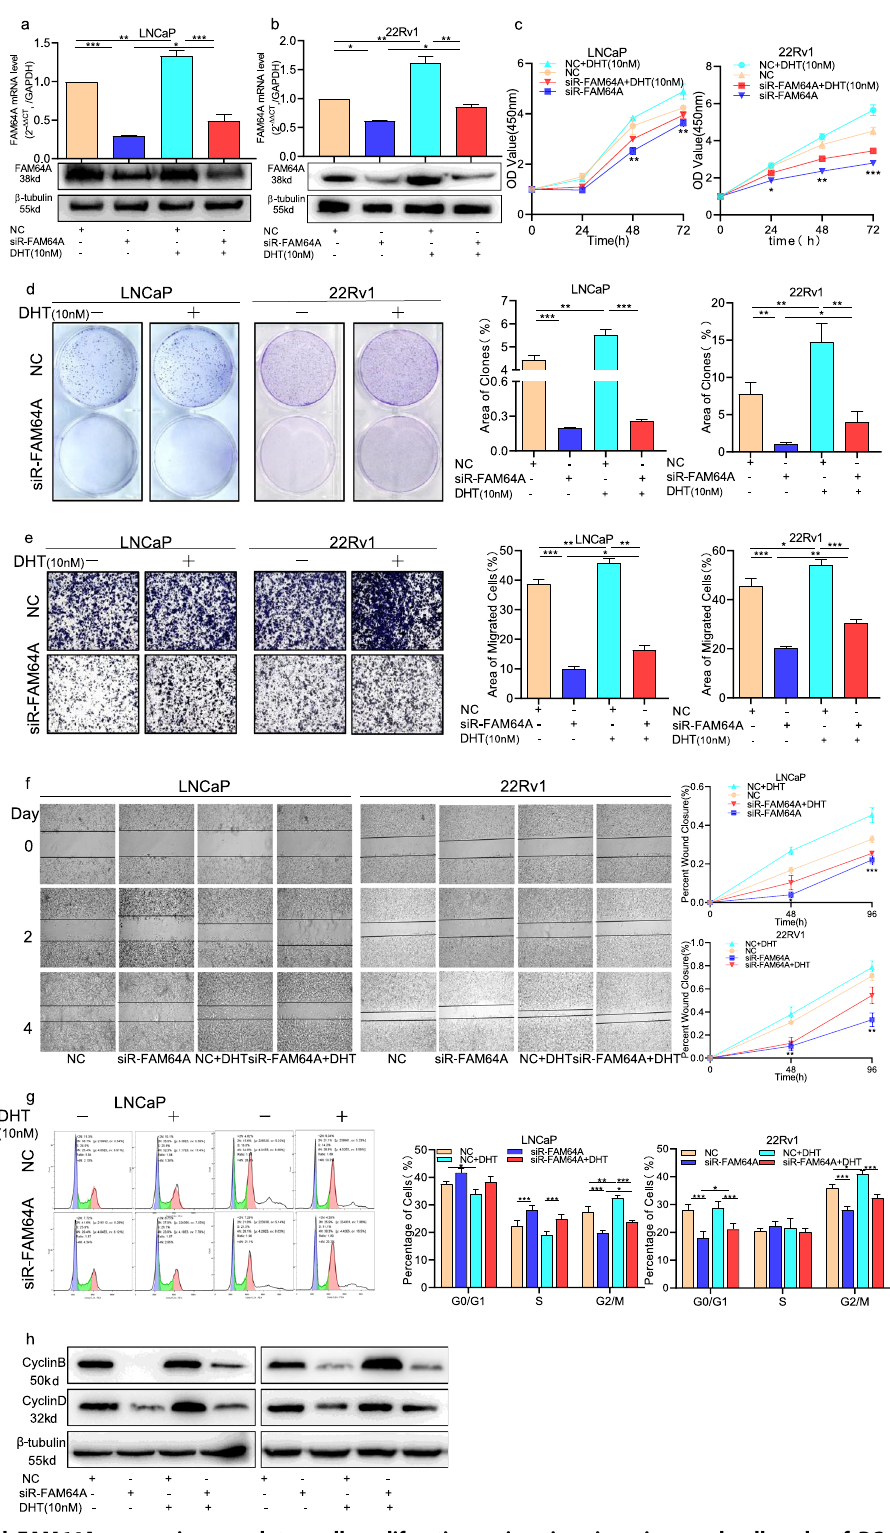
Fig. 4 AR-mediated FAM64A expression regulates cell proliferation, migration, invasion, and cell cycle of PCa cells. a , b The mRNA expression of FAM64A in cells transfected with siR-FAM64A and DHT (10 nM) at both transcription and translation levels. c , d CCK-8 assay and colony formation assay showed that DHT inhibits the effect of knocking out FAM64A on androgen-dependent PCa cell proliferation. e Transwell invasion assay indicated that DHT suppresses the effect of knocking out FAM64A about androgen-dependent PCa cell invasion. f Wound healing assay indicated that DHT restrains the effect of knocking out FAM64A about androgen-dependent PCa cell migration. g Flow cytometry analysis indicated that DHT moderates the effect of knocking out FAM64A on the progression of the androgen-dependent PCa cell cycle. h Western blot analysis showed that the FAM64A expression was upregulated after transfected DHT in siR-FAM64A or control siRNA PCa cells. * P < 0.05, ** P < 0.01, *** P < 0.001. Cell Death and Disease (2021)